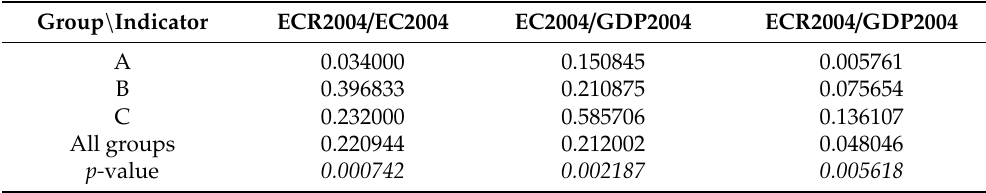
Table 6. Group averages for IRE in 2004.